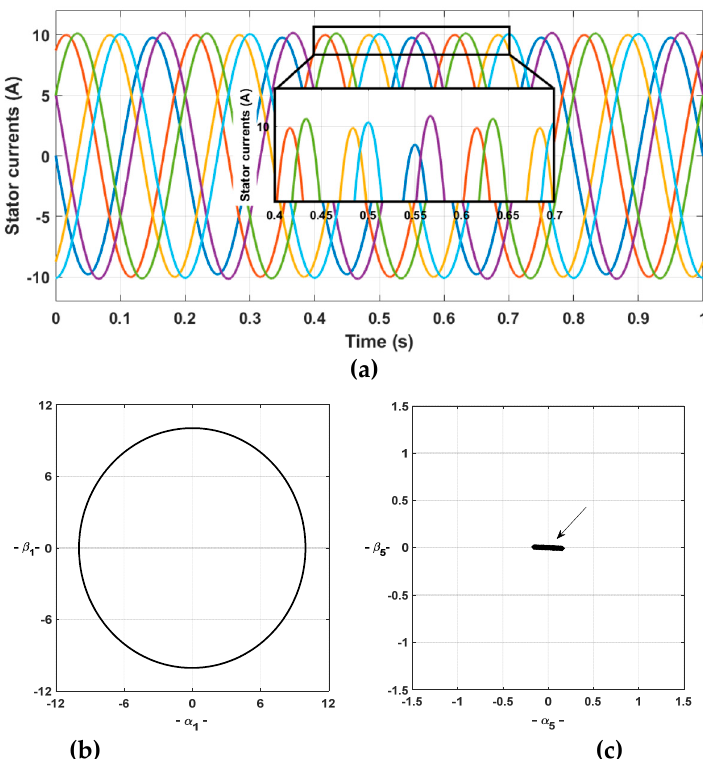
Figure 4. Simulation results: behavior of the drive using conventional FOC, under faulty phase-a1 with an additional resistance (R add = 0.7 pu): ( a ) Stator currents waveforms; ( b ) current space vector in α 1 – β 1 plane; ( c ) current space vector in α 5 – β 5 plane.